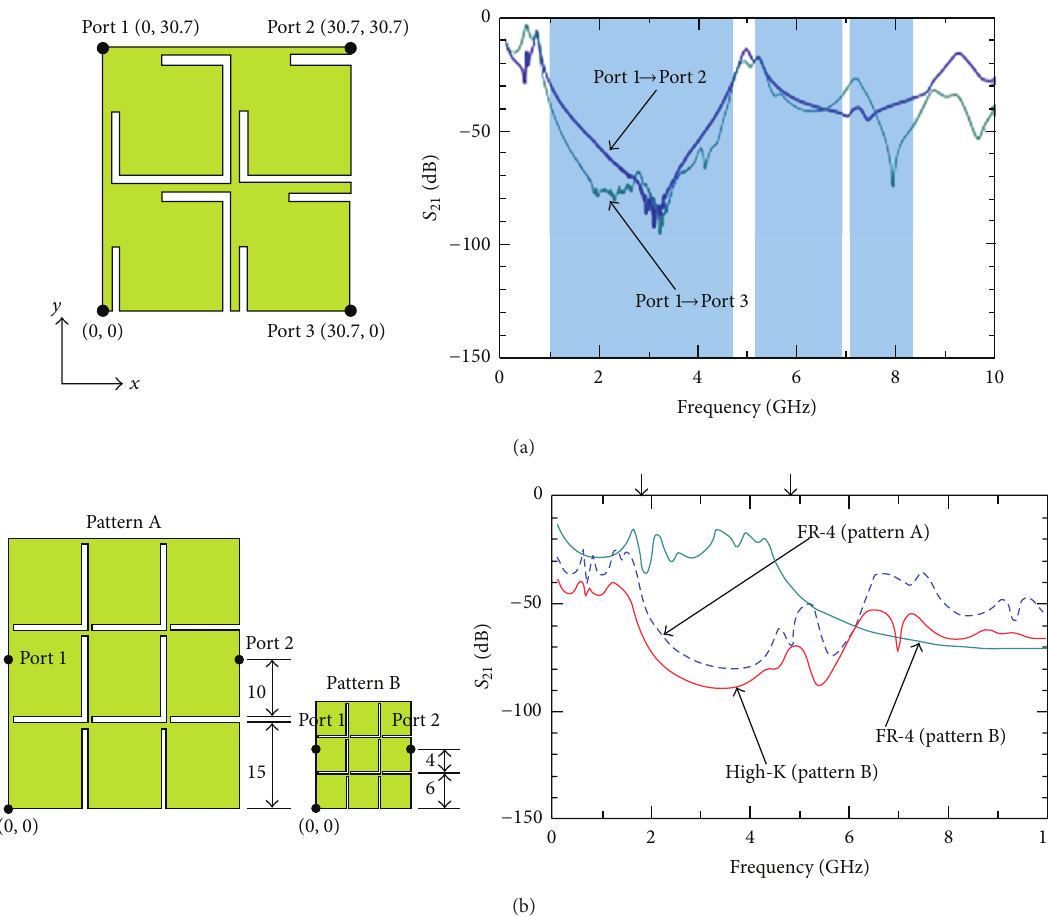
Figure 6: Calculated transmission coefficient ( 𝑆 21 ) (a) 2 × 2 array of EBG; (b) EBG without slits on different dielectric